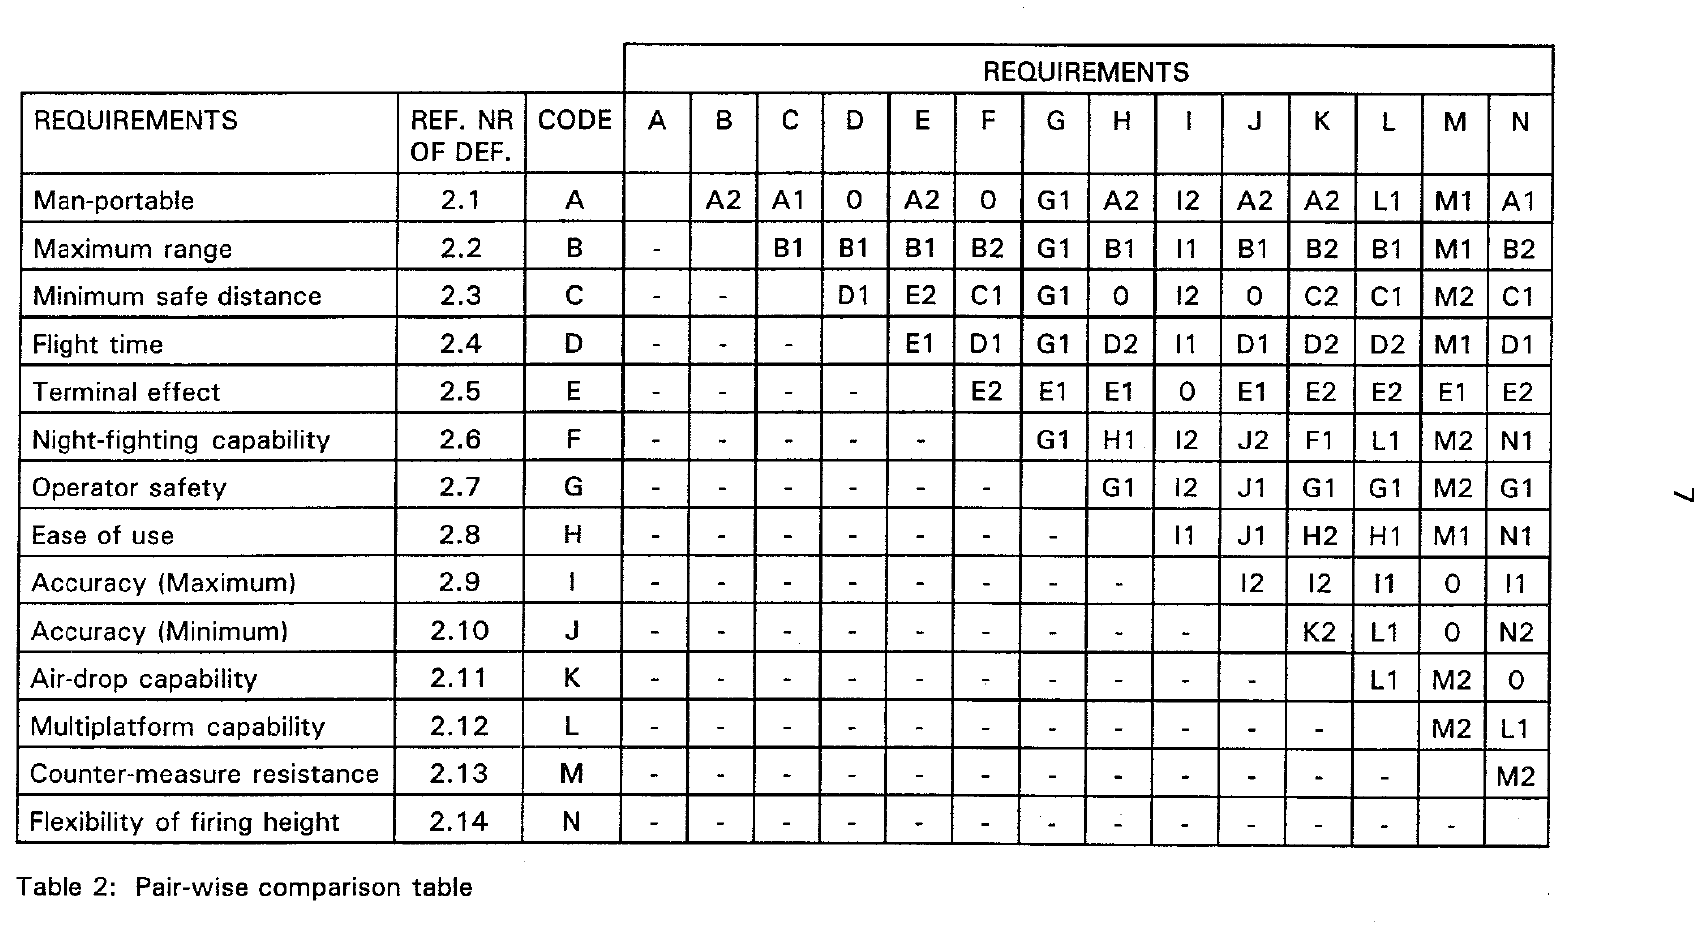
Table 2: Pair-wise comparison